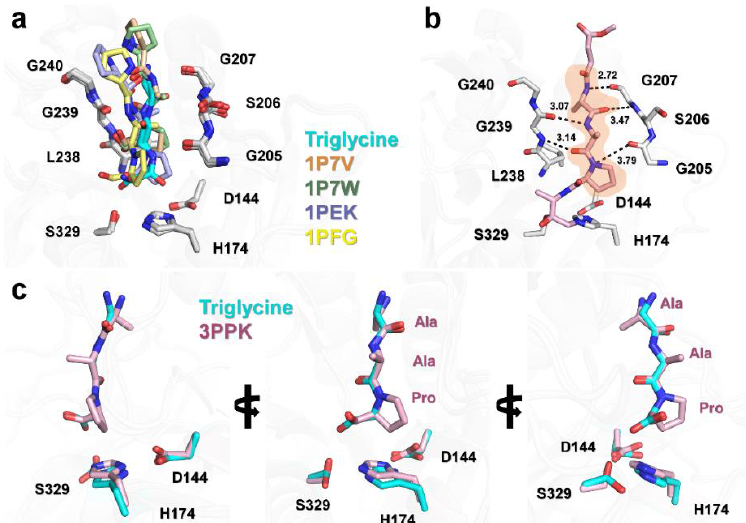
Figure 3. Structural comparison of the PaProK-triglycine complex with PaProK complexed with other peptide-based inhibitors. ( a ) Superimposition of PaProK-triglycine with partial sequence (Pro - Ala - Pro) from PaProK complexed with peptide-based inhibitors (PDB codes 1P7V, 1P7W, 1PEK, and 1PFG). ( b ) Inhibitor binding configuration of PaProK-3PPK. ( c ) Superimposition of the backbone of triglycine and Pro - Ala - Ala from the peptide-based inhibitor in PaProK-3PPK.